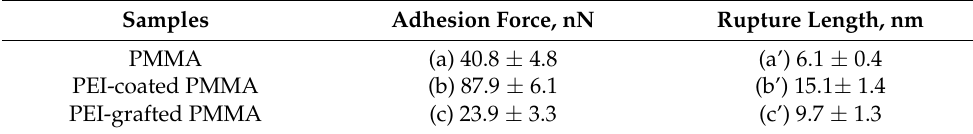
Figure 6. Force – distance plots of AFM measurements (retraction curves) for bare PMMA, PEI- Figure 6. Force–distance plots of AFM measurements (retraction curves) for bare PMMA, PEI-coated coated PMMA, and PEI-grafted PMMA. PMMA, and PEI-grafted PMMA. Table 3. Adhesion force and rupture length for bare PMMA, PEI, and PEI-grafted PMMA a